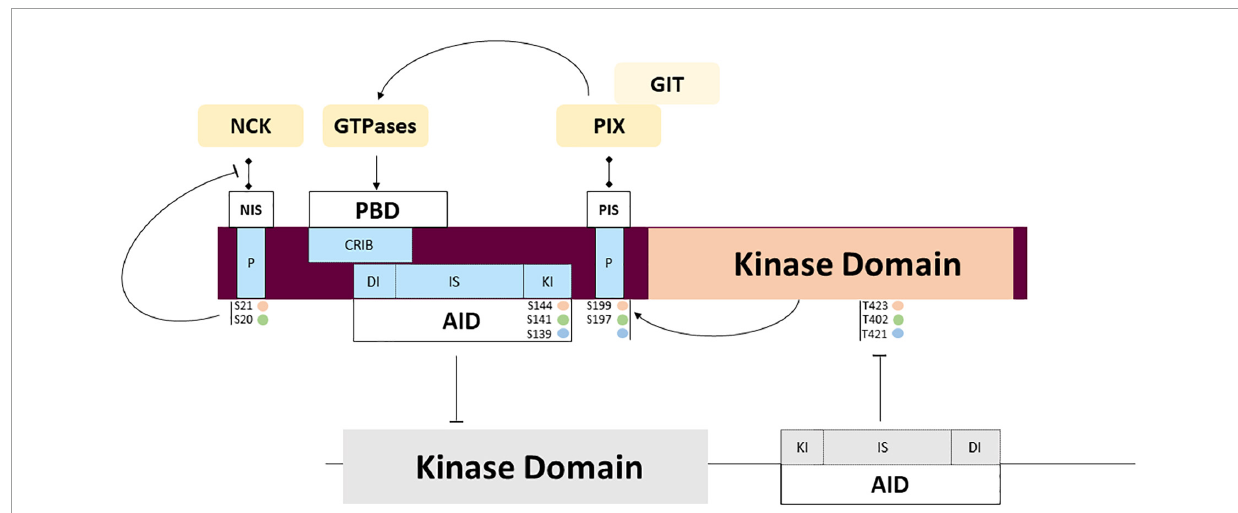
FIGURE4 PAK regulation through partner interactions and intramolecular signaling. Complex mechanisms of regulation are triggered by interaction with activators and adaptors that may regulate activity and subcellular location. Several auto phosphorylation sites also participate in the regulation of interaction with the partners mentioned above, and the transitory location and activation of PAKs. Phosphorylation sites corresponding to PAKl (orange), PAK2 (green) and PAK3 (blue).